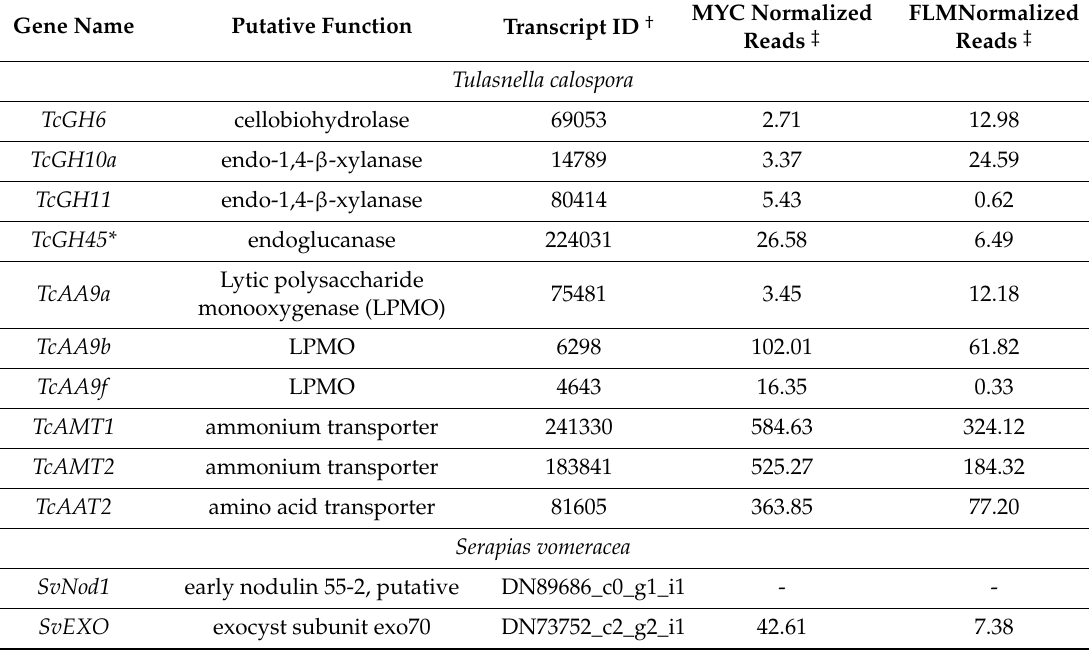
Table 2. CAZyme and symbiosis marker genes considered in RT-qPCR